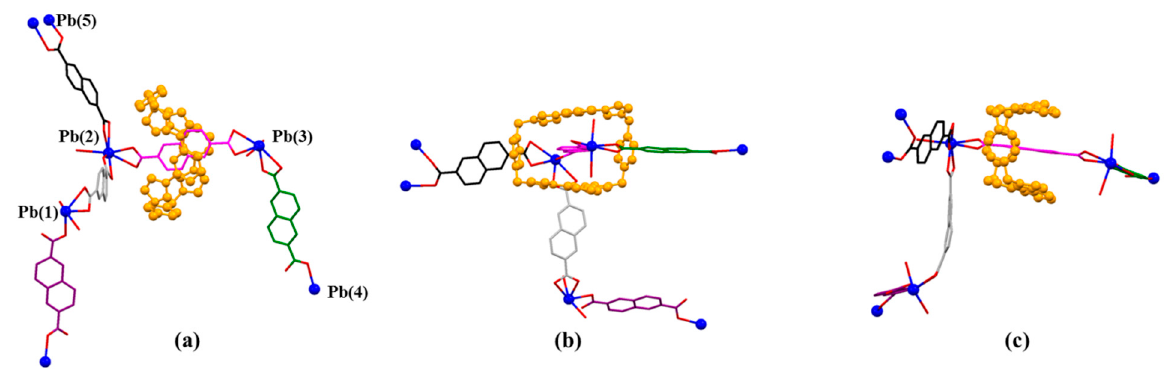
Figure 10. Top ( a ), side ( b ), and front ( c ) views of the monomer unit of MORF-Pb-2 formed from 1 4+ , 3 , and Pb 2+ . Note: Different colours are used for the linkage anions to illustrate the different local chemical environments. Solvent molecules and the protons have been omitted for clarity; none of these components are involved in the framework structure.